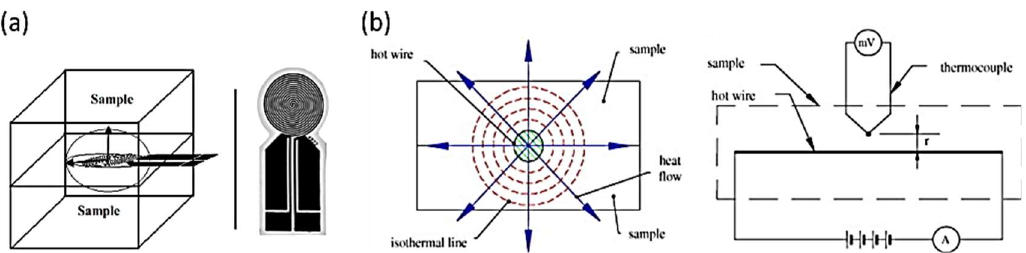
Figure 1 . ( a ) TPS measurement scheme. Reprinted with permission from Ref. [17] Copyright © 2008 WILEY-VCH Verlag GmbH & Co. KGaA; ( b ) Hot wire method scheme. Reprinted with permission from Ref. [18] Copyright © 2007, Elsevier.